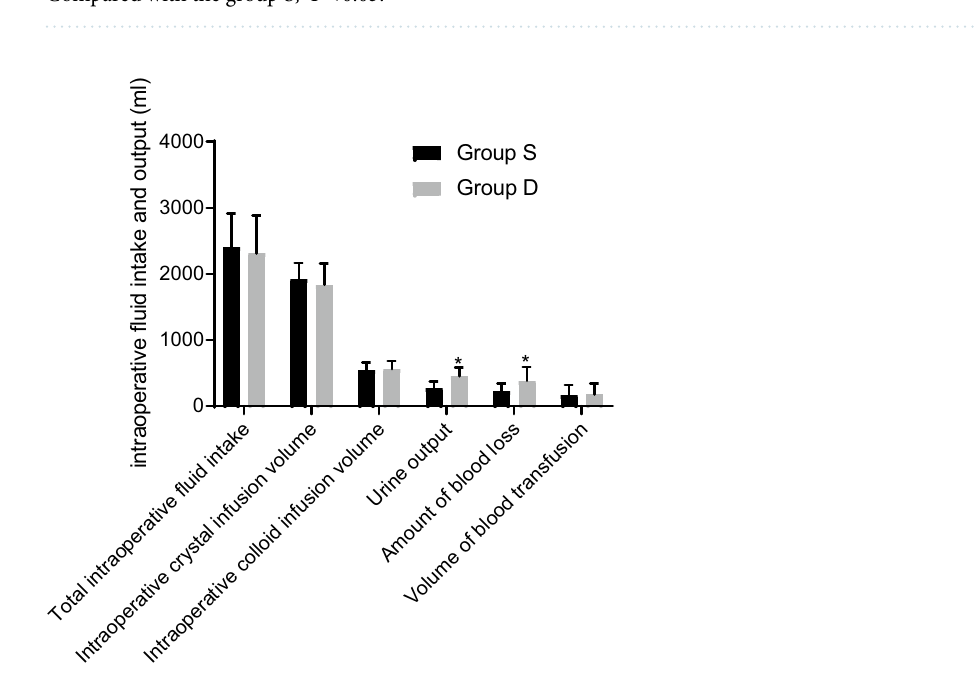
Figure 1. Intraoperative volume input and output of the two patient groups. Compared with the S group, the intraoperative blood loss in the D group was reduced, while the intraoperative urine volume was significantly increased. In addition, the difference was statistically significant (compared with the S group, * P < 0.05). However, there was no significant difference in the total fluid input, crystalloid infusion volume, colloid infusion volume and blood transfusion volume between the two groups ( P >